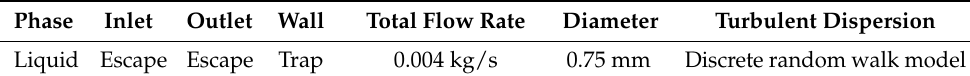
Table 7. Model setting and boundary condition for the discrete phase in the DPM